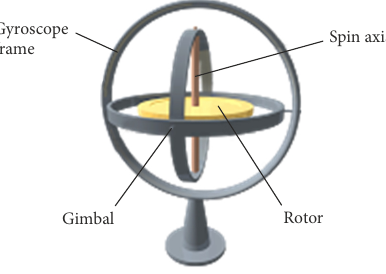
Figure 1. Structure of a